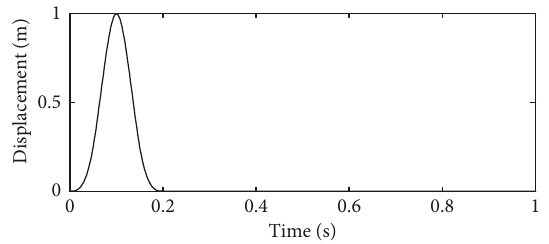
Figure 4: Displacement time history of the incident impulse